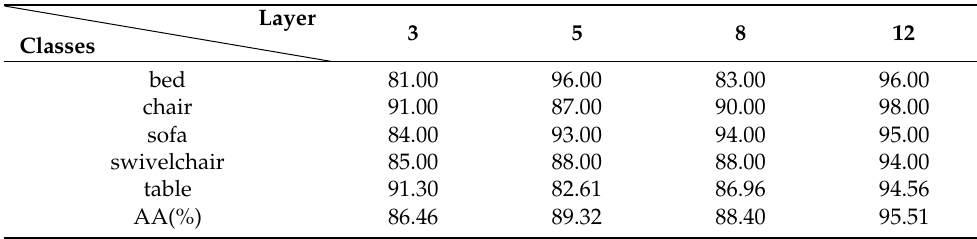
Table 3. The classification accuracy comparison of depthwise group over-parameterized convolution in different